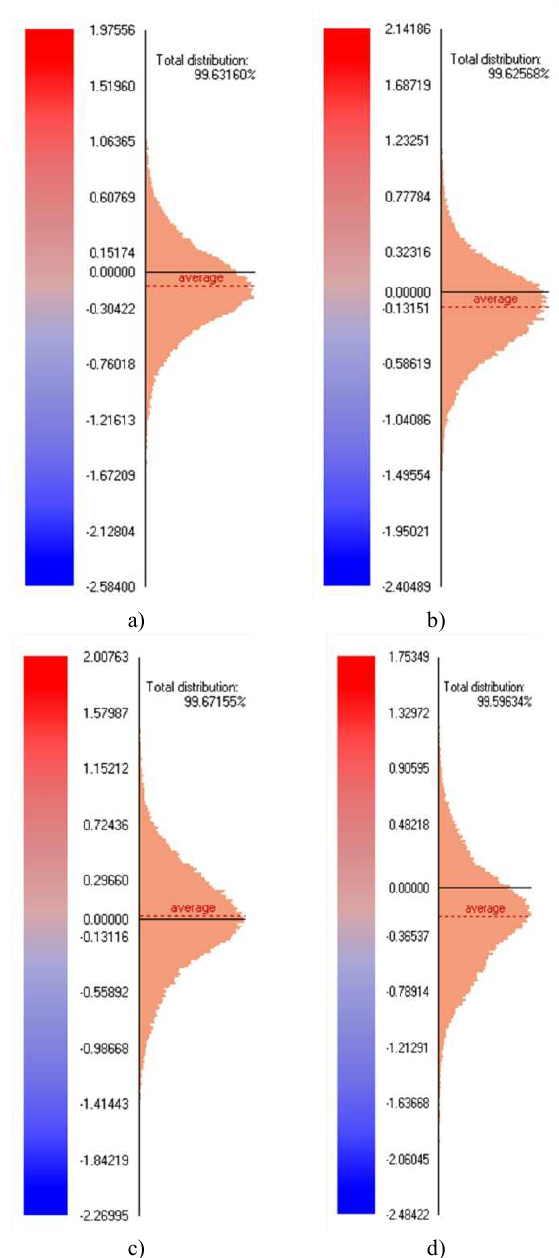
Figure 4. Histograms showing differences in orthometric heights for the comparison between LiDAR DSM and GeoEye- 1 DSM. a) RPC0 and 7 GCPs, b) RPC0 and 12 GCPs, c) CCRS and 12 GCP), d) CCRS and 45